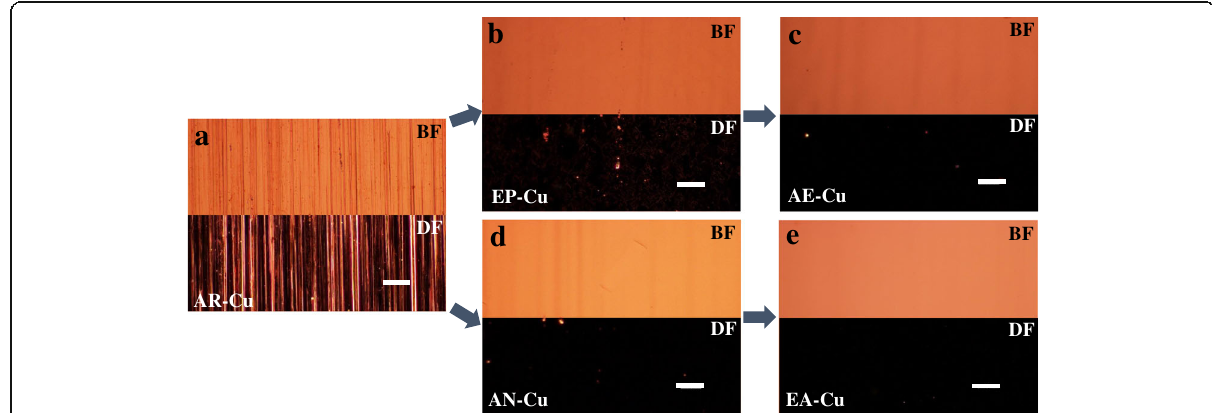
Fig. 1 OM images of Cu foils with different pre-treatments under bright and dark fields. a AR-Cu, b EP-Cu, c AE-Cu, d AN-Cu, and e EA-Cu, respectively. Scale bars, 20 μ